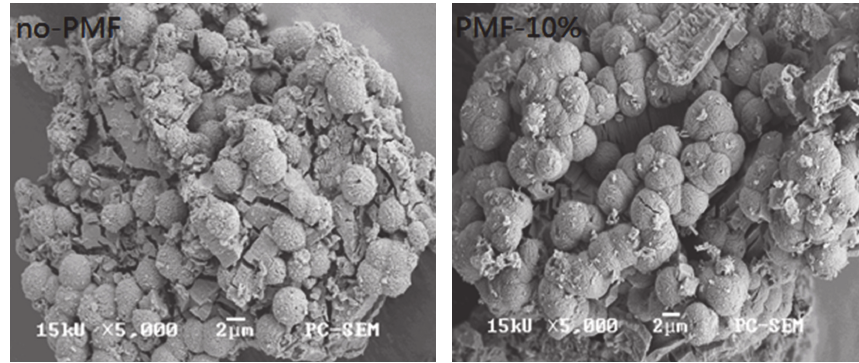
Figure 2: FE-SEM images of prepared LiNi 0.5 Mn 1.5 O 4 .